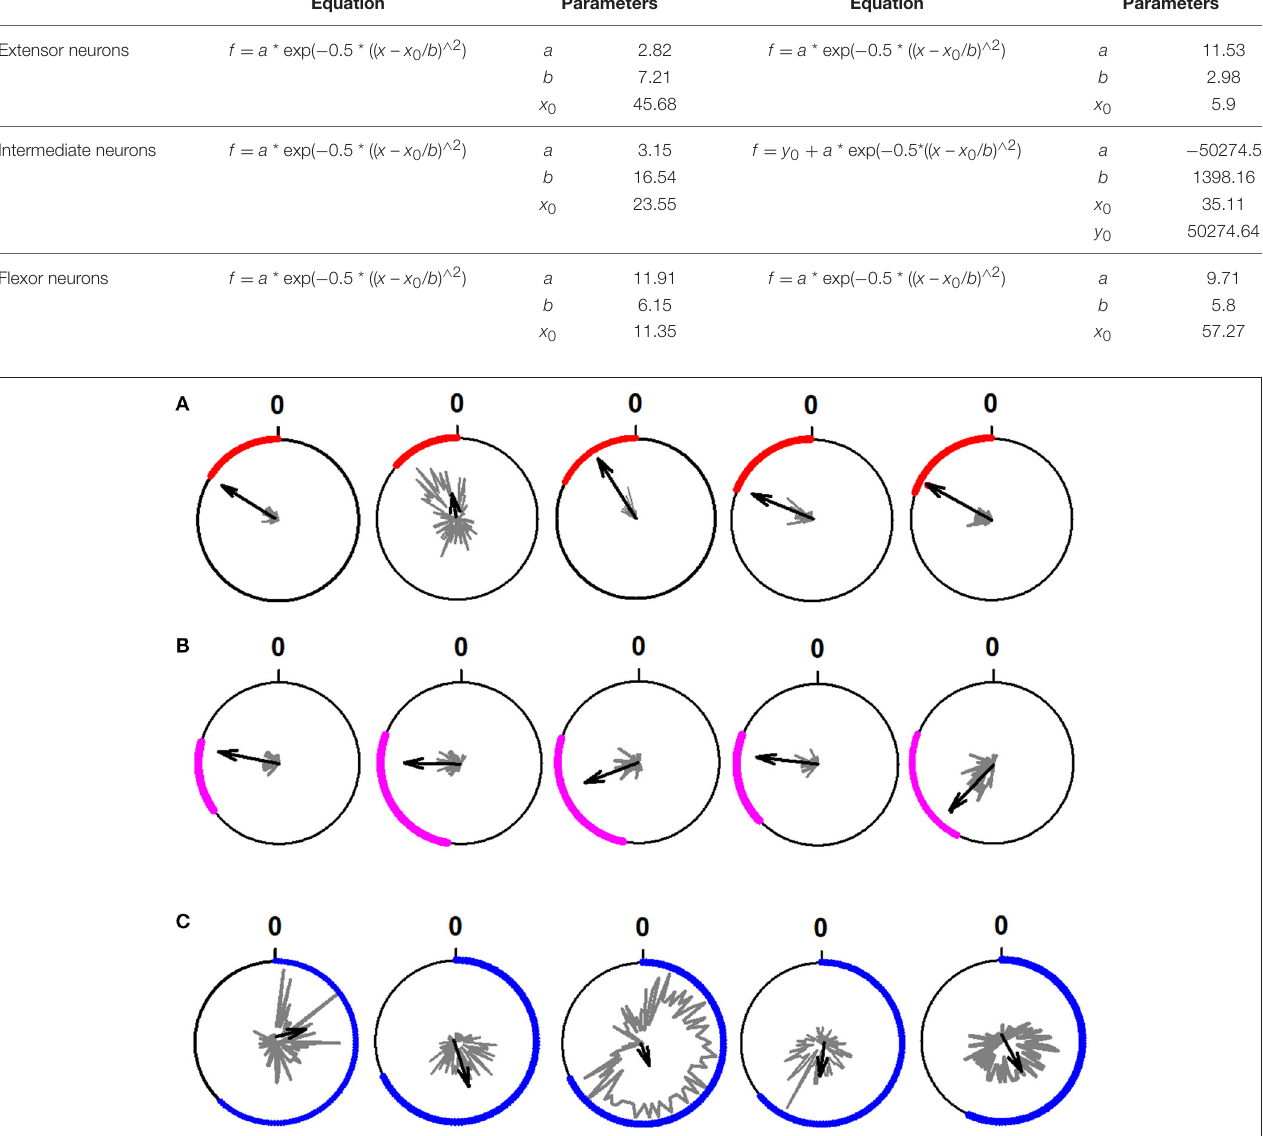
TABLE 2 | Gaussian equations and fitting parameters for the distributions illustrated in Figure 4 . Before During Equation Parameters Equation Parameters